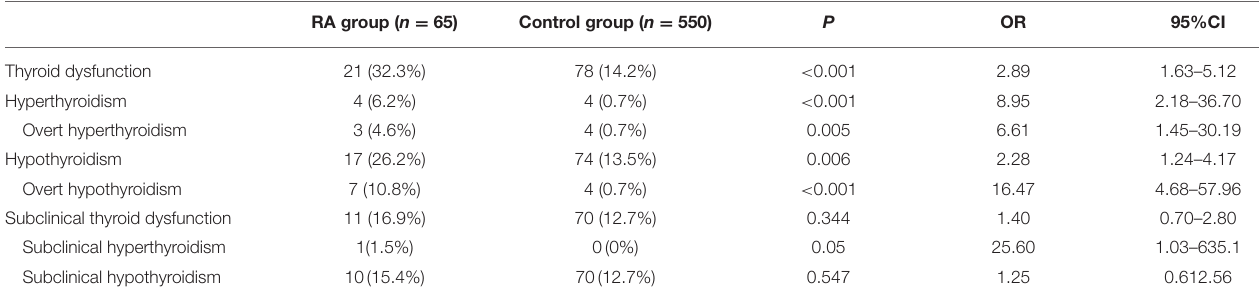
TABLE 2 | The prevalence of thyroid dysfunction and its subgroup in RA patients and